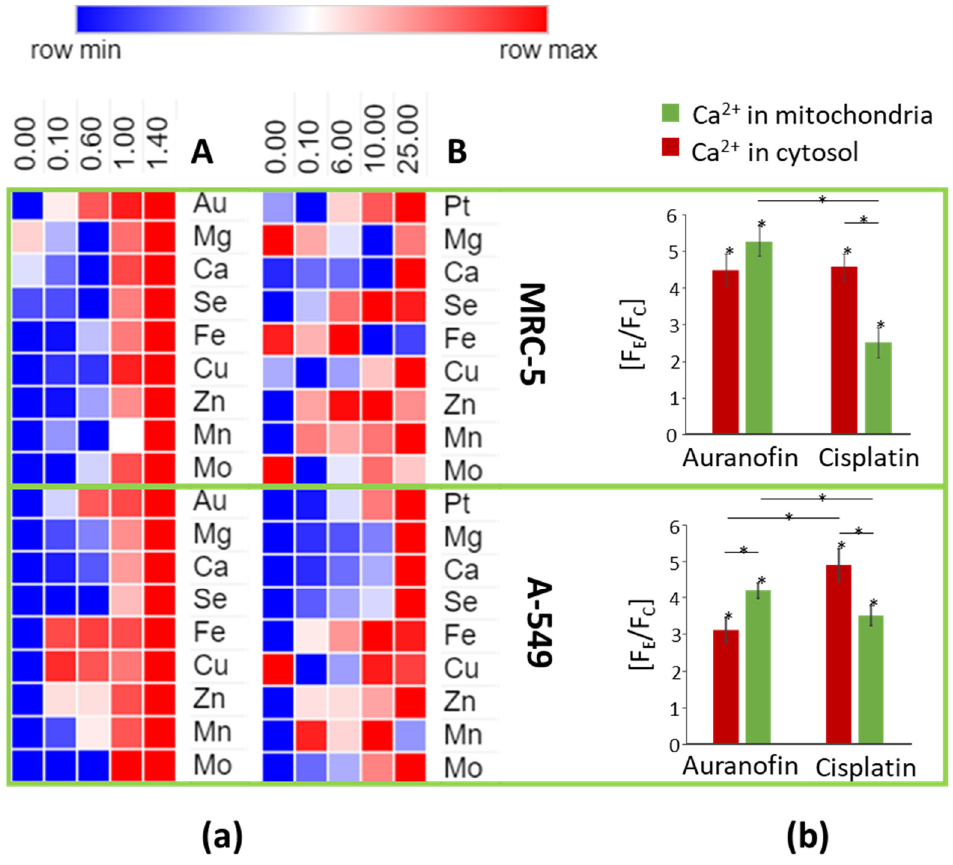
Figure 5. Heat-map showing changes of relative metal amounts in lysates of cells exposed to auranofin ( a ) and cisplatin ( b ) obtained with Morpheus software (https://software.broadinstitute.org/morpheus, accessed on 1 December 2021) [52]. Changes of Ca 2+ (and other metals) amounts in cytosol and mitochondria established as the ratio of the fluorescence obtained for cells exposed to auranofin and cisplatin (F E ) against fluorescence obtained for the control group (F C ). *— p < 0.05.